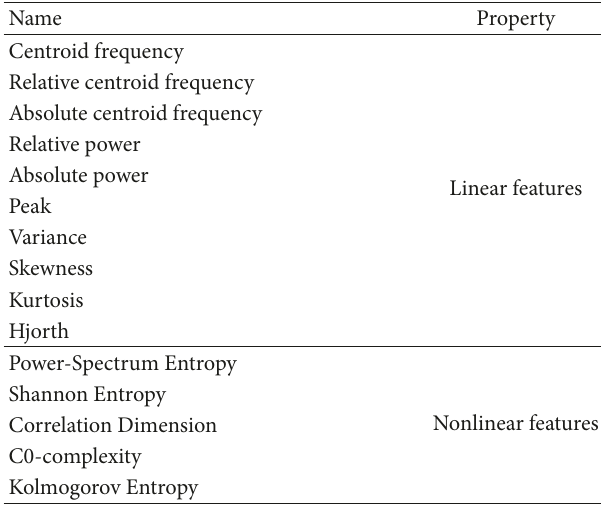
Table 2: Features used in the feature extraction